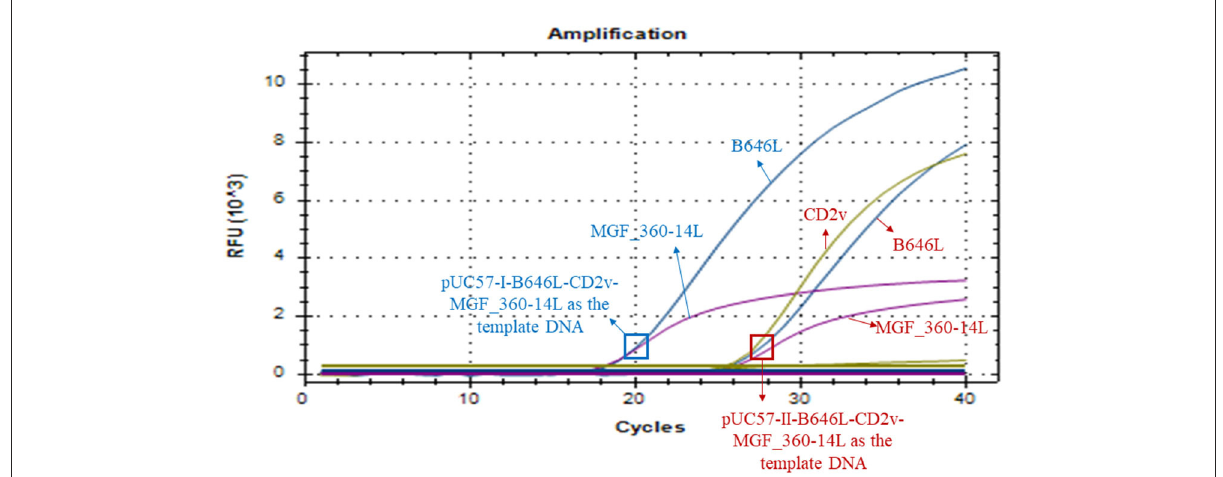
FIGURE6 Amplification curves of triplex real-time PCR assay on detecting B646L, CD2v, and MGF_360-14L from ASFV genotype I strains. The result of the method using a plasmid containing B646L, CD2v, and MGF_360-14L (pUC57-I-B646L-CD2v-MGF_360-14L) from ASFV genotype I strains is shown in blue, while result of the method using a plasmid containing B646L, CD2v, and MGF_360-14L (pUC57-II-B646L-CD2v-MGF_360-14L) from ASFV genotype II strains is shown in red.